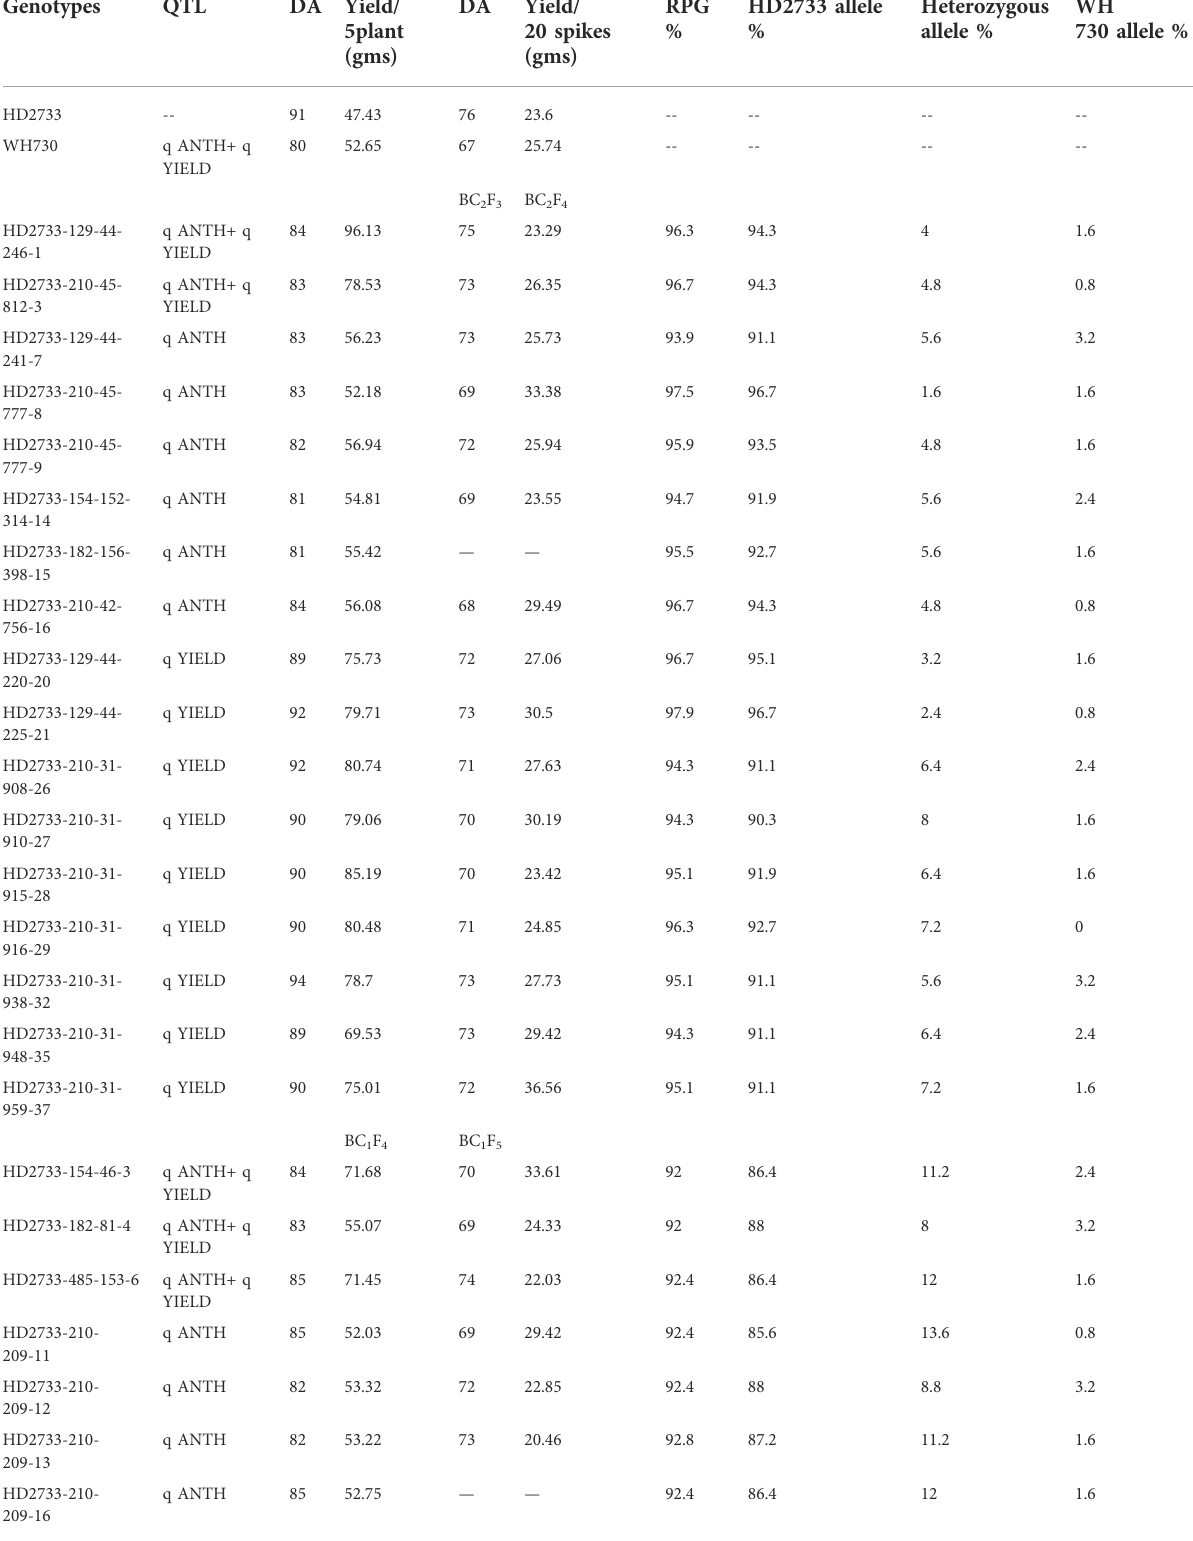
TABLE 6 Performance of the targeted traits and genomic constitution of MABB-derived lines.